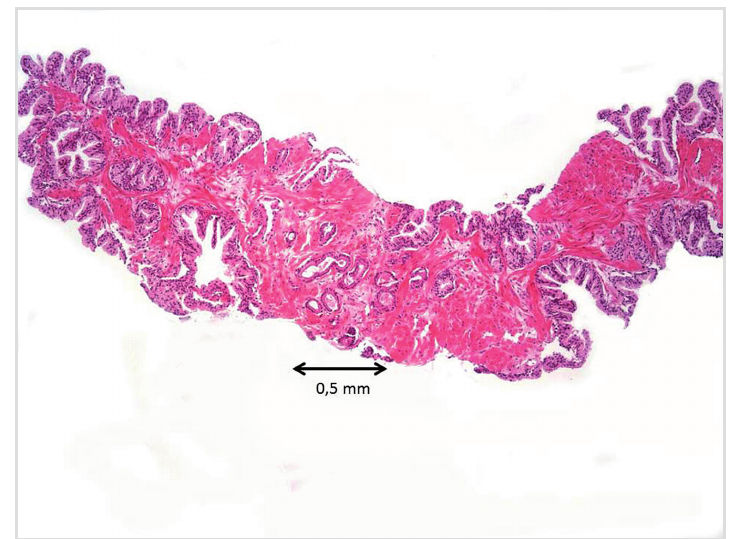
Figure 1 - Illustration of a focus of adenocarcinoma in a biopsy core measuring 0.5 mm and corresponding 4.5% of the total linear extent of the fragment which measured 11 mm